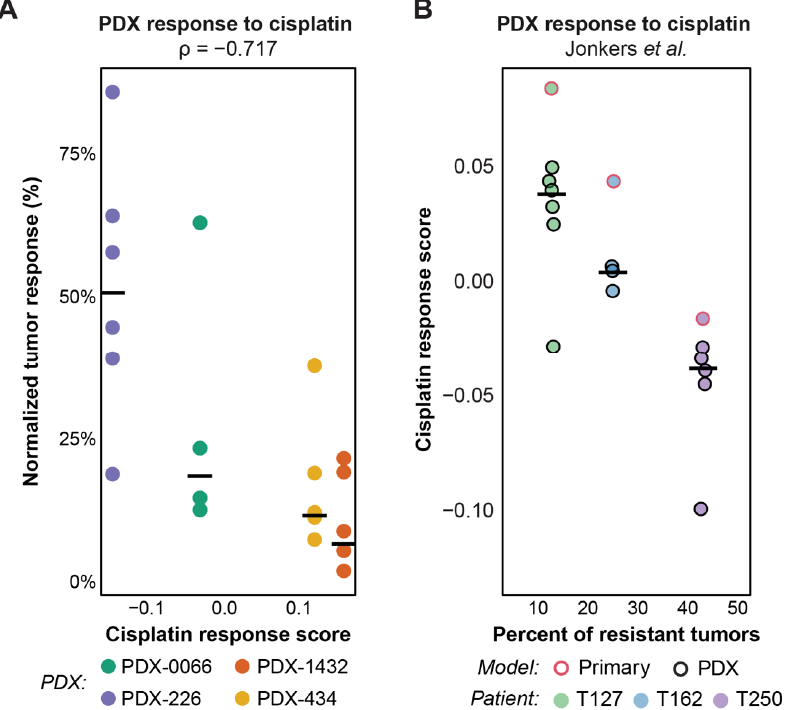
Figure 4. Cisplatin efficacy scores in pre-clinical models accurately discriminate between responsive and resistant tumors. ( A ) Cisplatin efficacy scores for individual mice bearing one of four PDX tumors are anti-correlated with median estimates of NTR (normalized tumor response), estimated from growth curves (Figure S5). ( B ) Cisplatin efficacy scores discriminate between BRCA1-deficient PDX models based on their likelihood to respond to the drug. Efficacy scores are inversely correlated with the proportion of resistant tumors (defined in 47) and thus are predictive of resistance in BRCA1-deficient models.